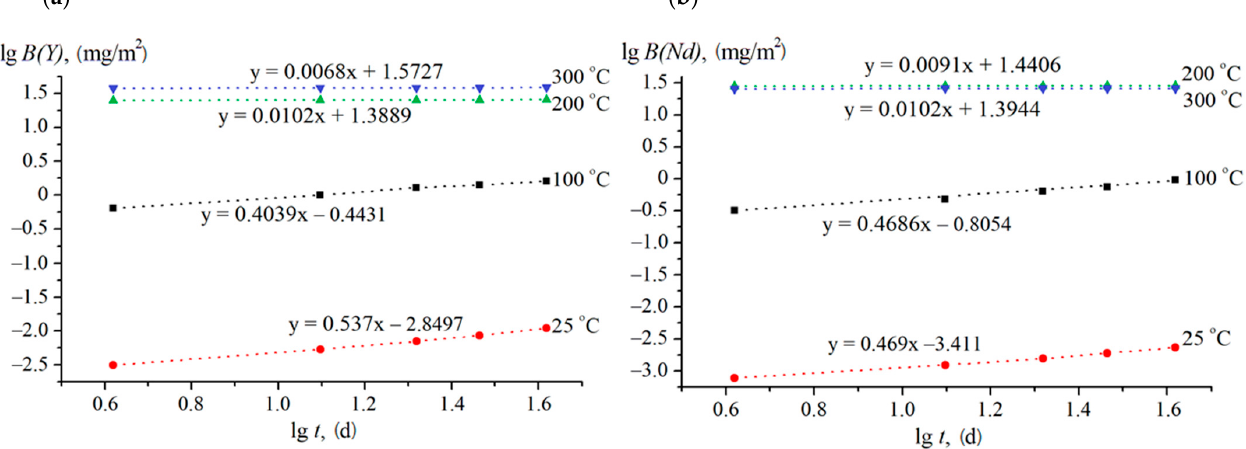
Figure 7. Logarithmic dependence of Y ( a ) and Nd ( b ) yield on the time of contact with water.